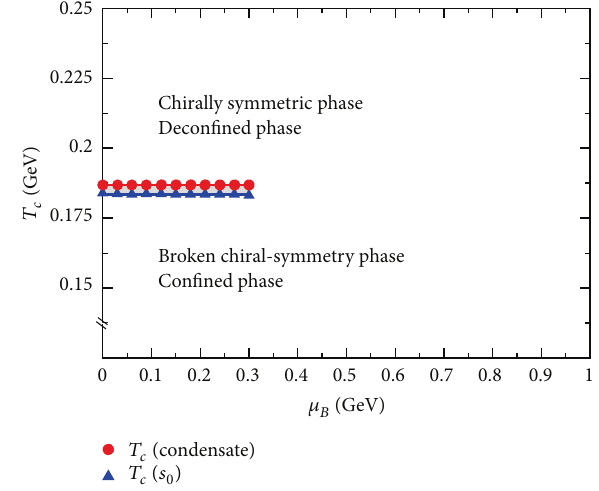
(𝑇,𝜇 ) , as functions of the 0 𝑞